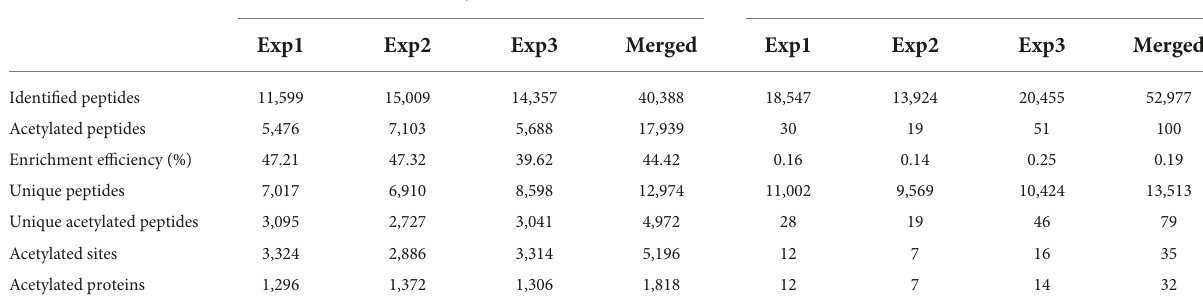
TABLE 1 Statistics of acetylome and proteome of the C57BL/6 mouse